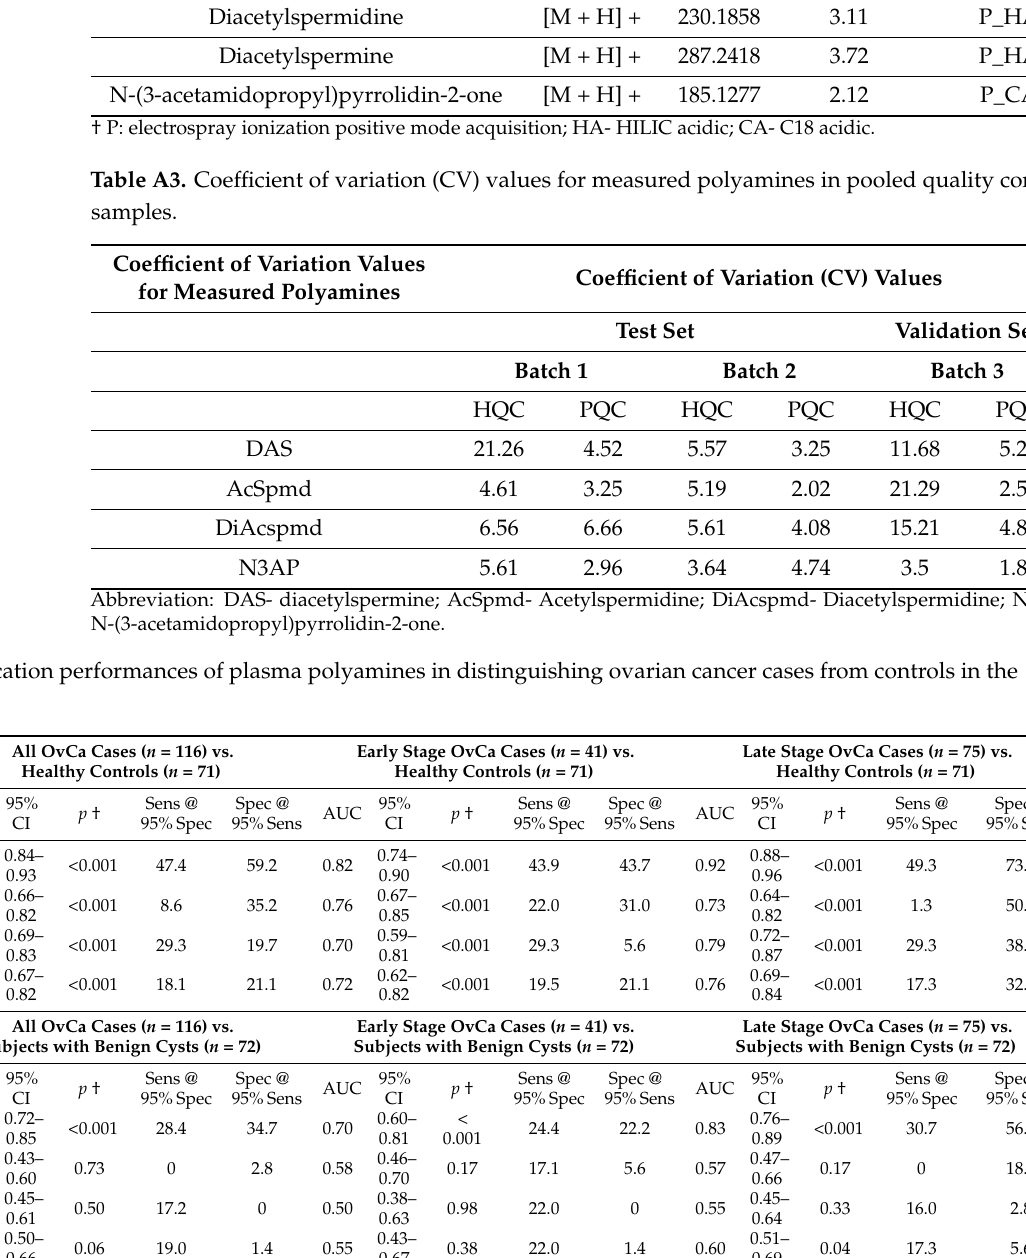
Table A2. Polyamines detected and measured by liquid chromatography mass spectrometry.